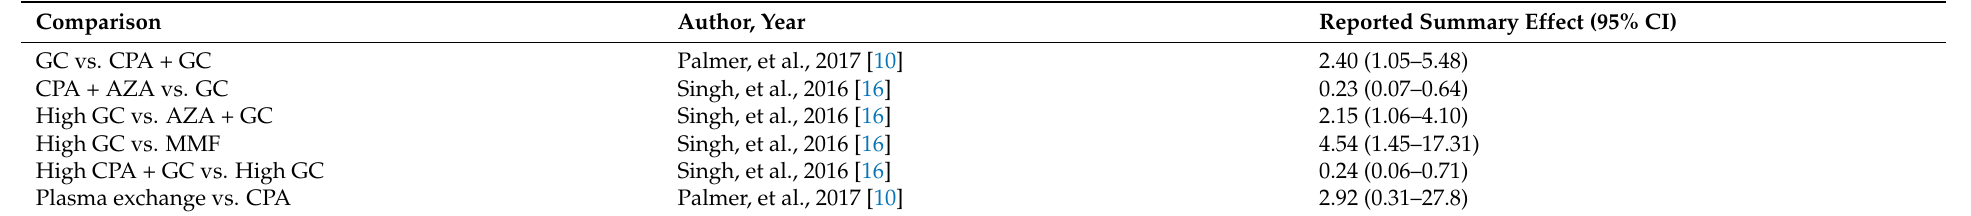
Table 10. Progression to ESRD during treatment of lupus nephritis (Network